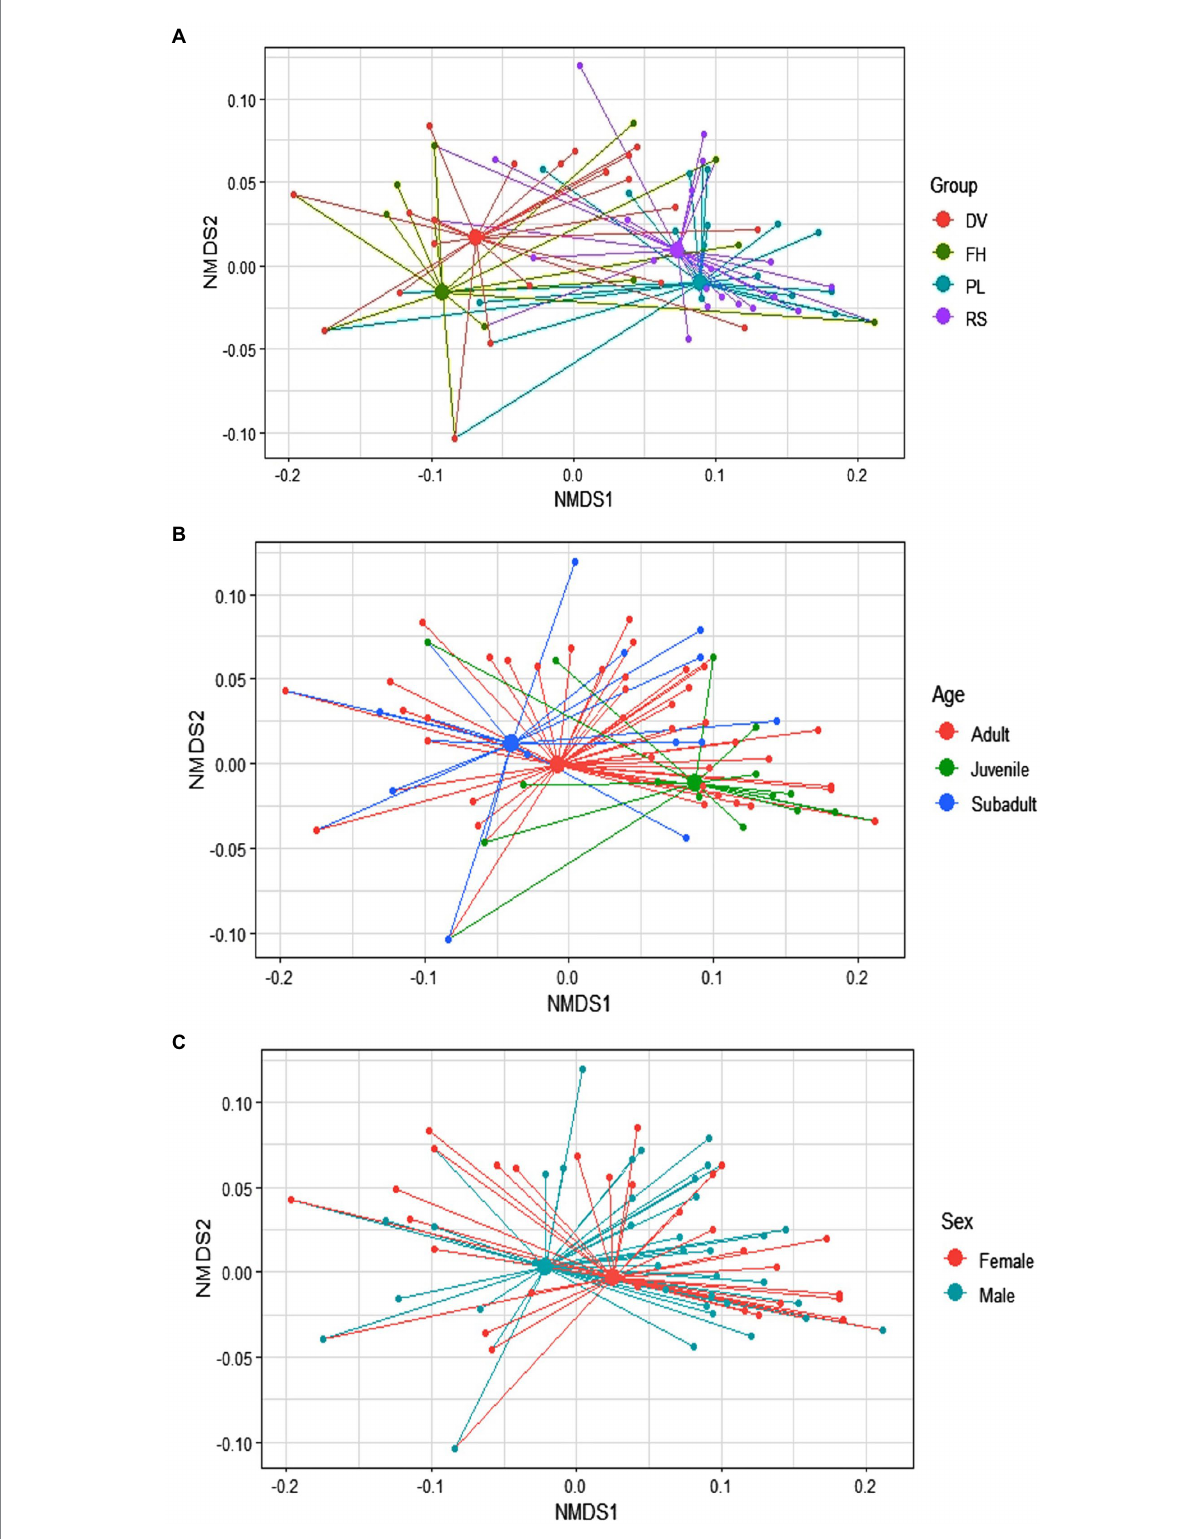
FIGURE 2 Variability of the 123 events of bottle-directed manipulative techniques, displayed by the study bonnet macaque population during Task I, as indicated by the distance of individual values (small solid circles) from the mean values (large solid circles) within the three considered variables of group membership (A) , age class (B) , and sex class (C) . These spider diagrams represent two-dimensional Non-metric Multi-Dimensional Scaling (NMDS) plots of the three variables, represented by different